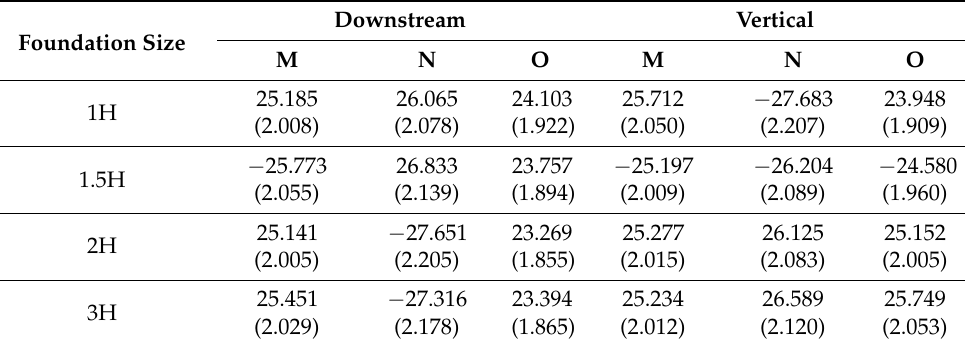
Figure 12. The Koyna earthquake displacement and velocity time history. Theoretically, the PGA at the observation points should be twice that of the input as the seismic excitation is transmitted to the foundation surface. However, Table 6 shows that there are some discrepancies between the theoretical and observed PGAs, and in general the error is the smallest for the foundation with a size of 3H.